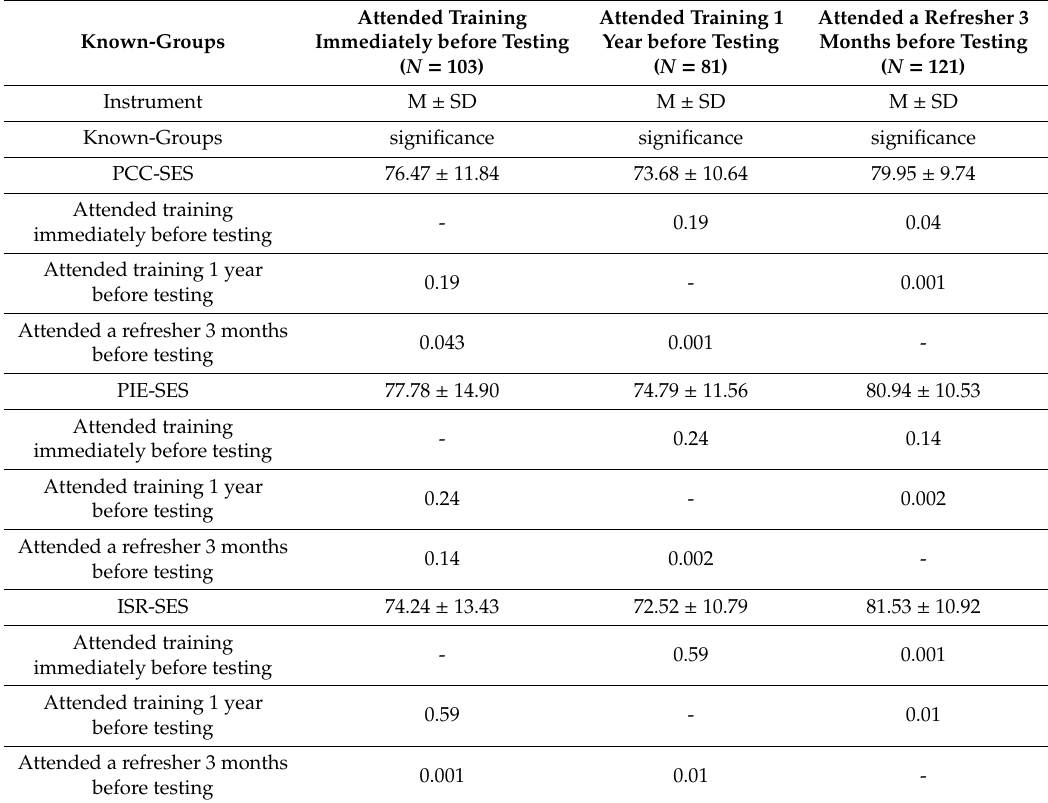
Table 5. Known groups analysis and Tukey’s HSD post-hoc test for multiple